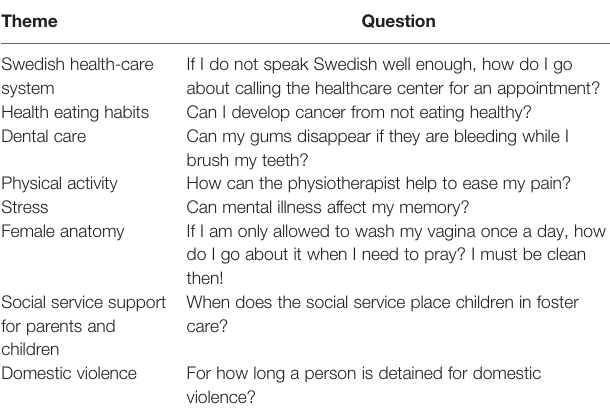
TABLE 1 | Illustrations of questions from participants related to the different themes